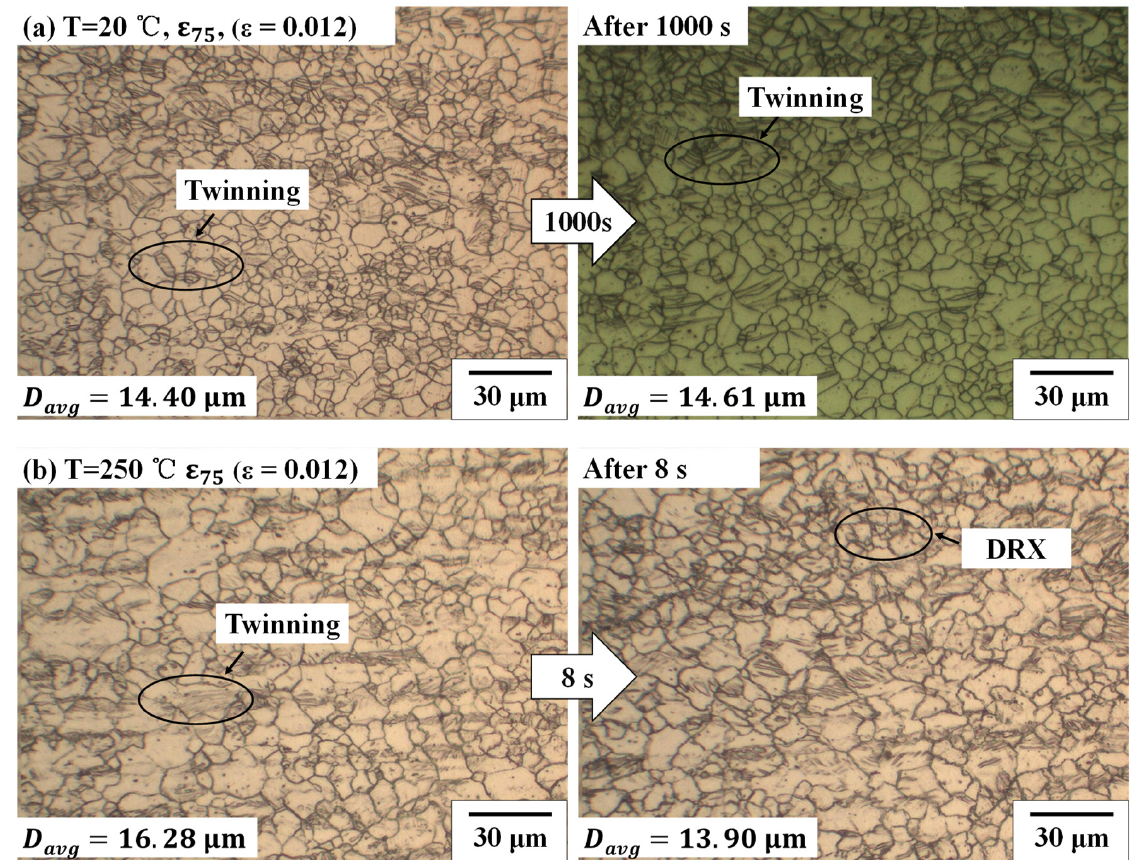
Figure 11. Change of the microstructure after the creep test with the pre-strain of ε 75 ( ε = 0.012) ( a ) at 20 °C with the holding time of 1000 s and ( b ) at 250 °C with the holding time of 8 s.